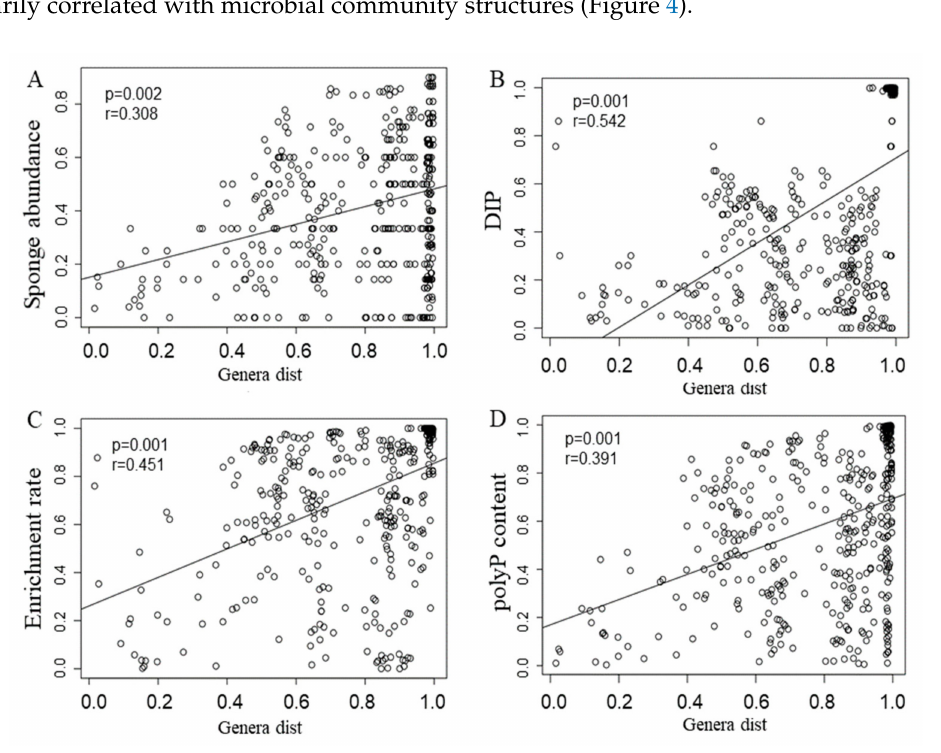
Figure 3. Mantel Test on the relationship between bacterial diversity at the level of genus and environmental factors. The X-axis presented a distance metric of taxonomic composition. ( A ) sponge abundance; ( B ) Dissolved inorganic phosphorus; ( C ) enrichment rate of